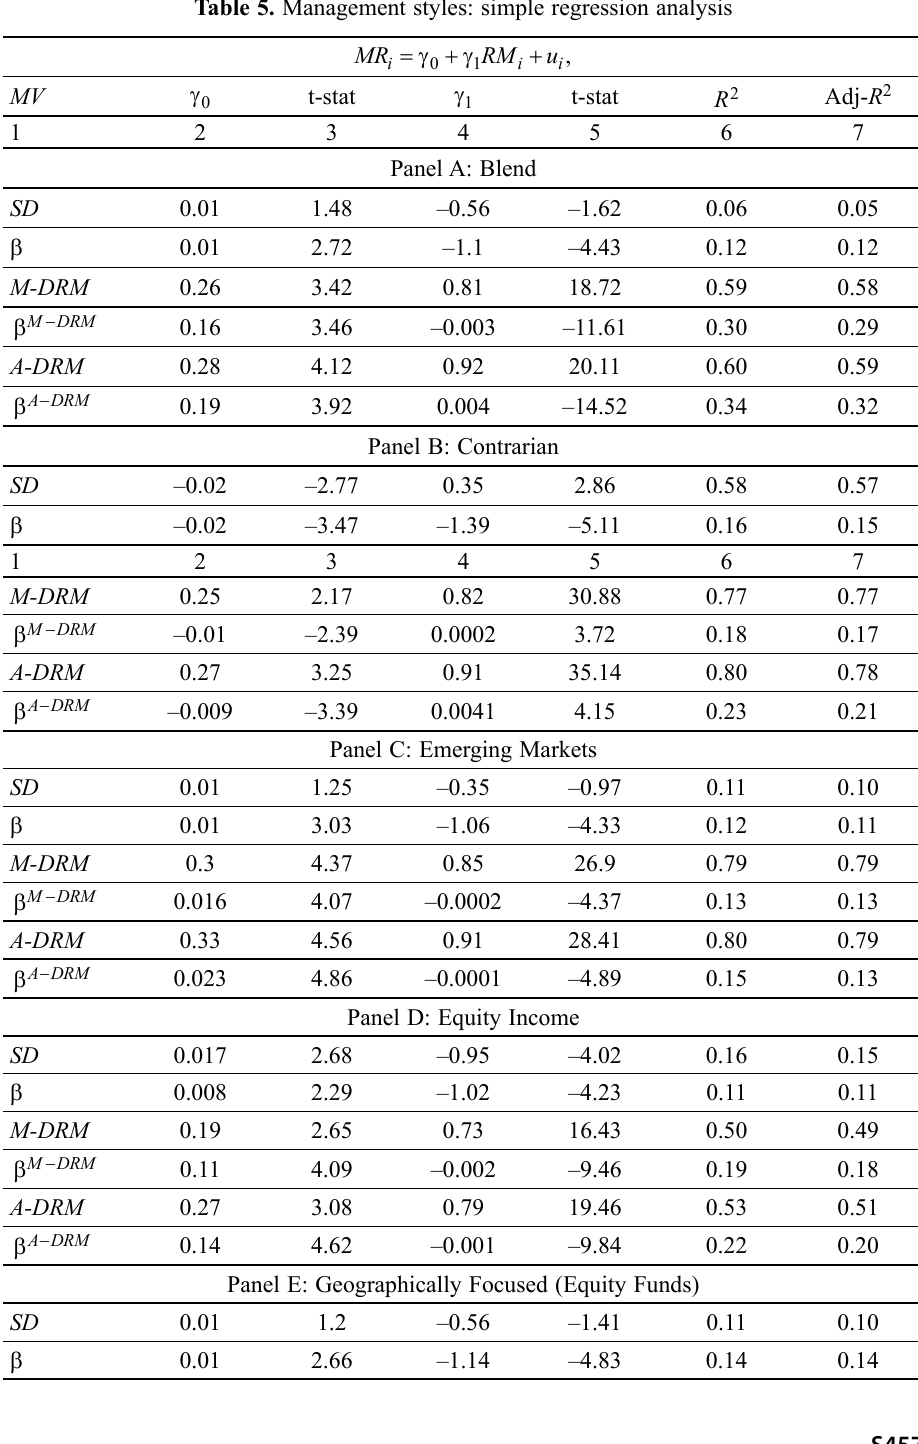
Table 5. Management styles: simple regression